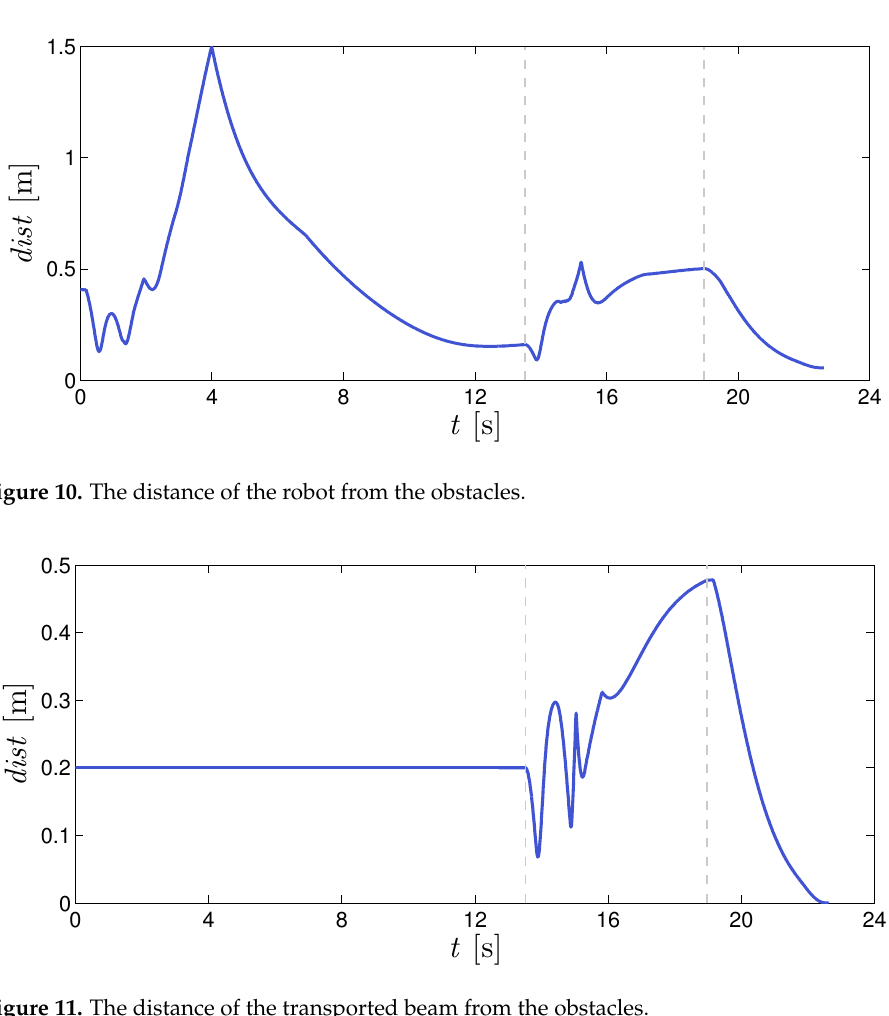
Figure 12. Changes of configuration variables for the torso.